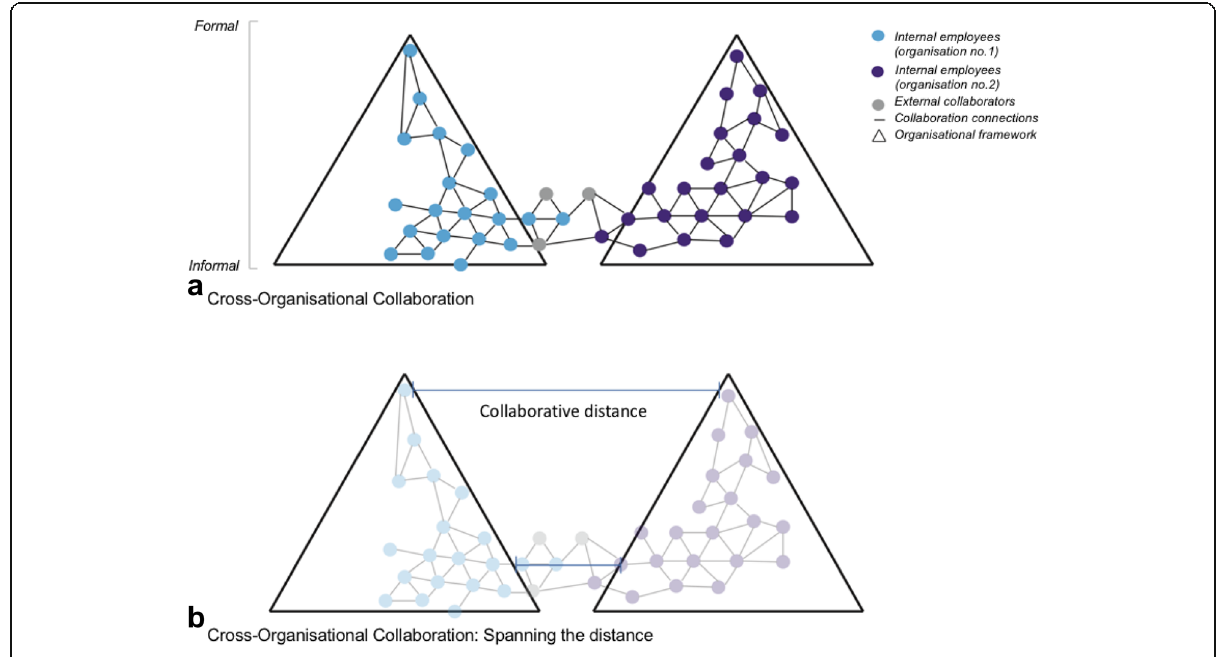
Fig. 2 Cross-organisational collaboration, and collaborative distance. Derived from Braye (Interview 2016) and Johnson (Interview